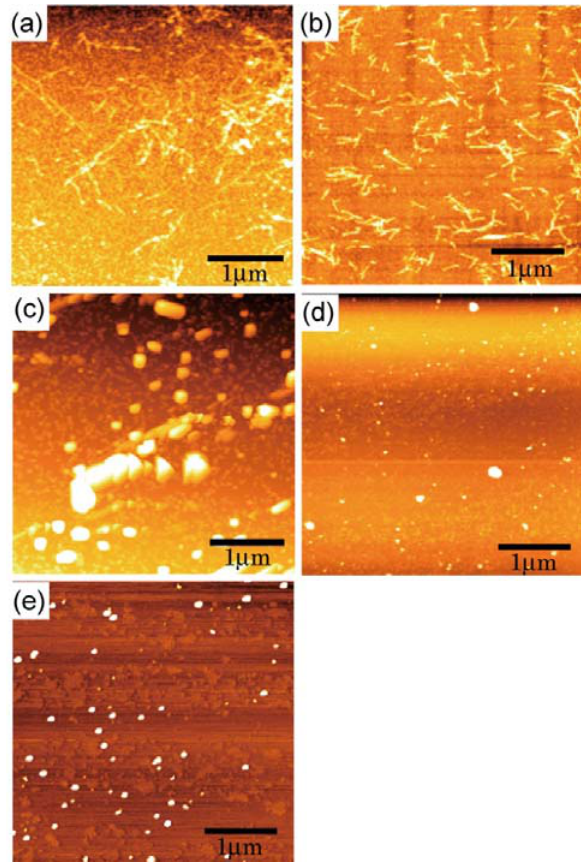
Figure 6. AFM observations of A β (1-42) (20 μ M) ( a ) in the absence of an additive, ( b ) in the presence of pNP-6S-GlcNAc (200 μ M), ( c ) in the presence of G0 (200 μ M), ( d ) in the presence of G1 (200 μ M), and ( e ) in the presence of G2 (200 μ M).